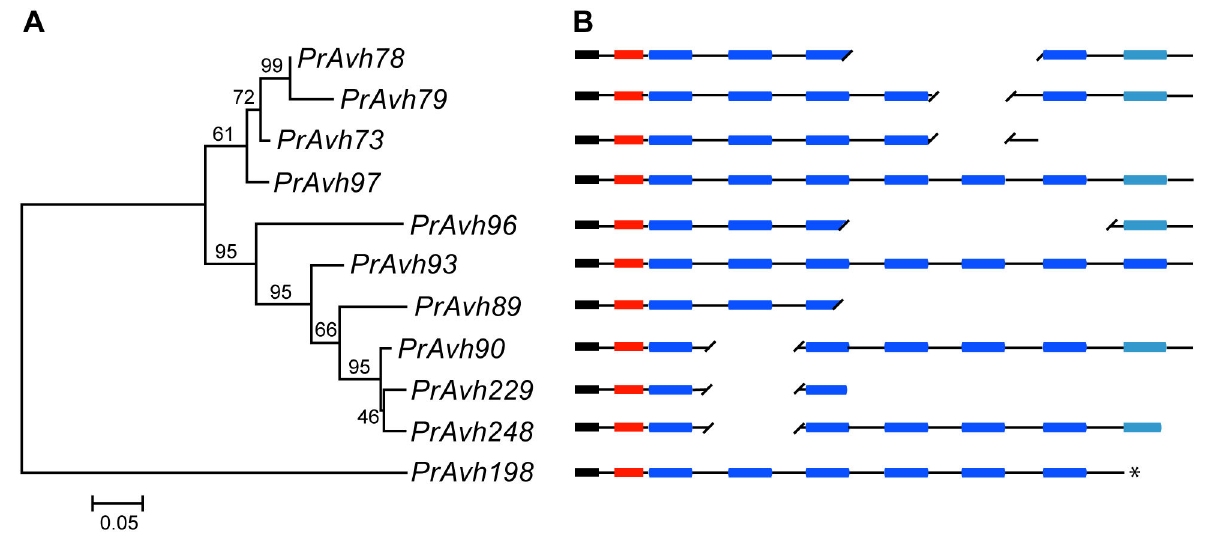
Figure 1. P. ramorum RXLR effector family with insertion/deletion of domains. Evolution in the domain structure of effectors is evident by comparing the phylogeny of the genes to their composition. A. The ancestral relationships among the genes inferred from a maximum likelihood tree of the targeting region (signal peptide through RXLR-DEER) with indels removed. Branch support is shown as a percentage of 500 bootstrap samples. The branch lengths are drawn to scale and measured in the number of substitutions per site. B. Schematic showing the aligned domain structure of the genes (not to scale). Gaps in the alignment are indicated using forward slashes. Colors of domains are: black – signal peptide, red – RXLR-DEER, and blue –WY-domain. WY- domains in lighter shade indicate low scoring matches to the HMM. * PrAvh198 was at the end of a scaffold and is missing the 3’ end of the